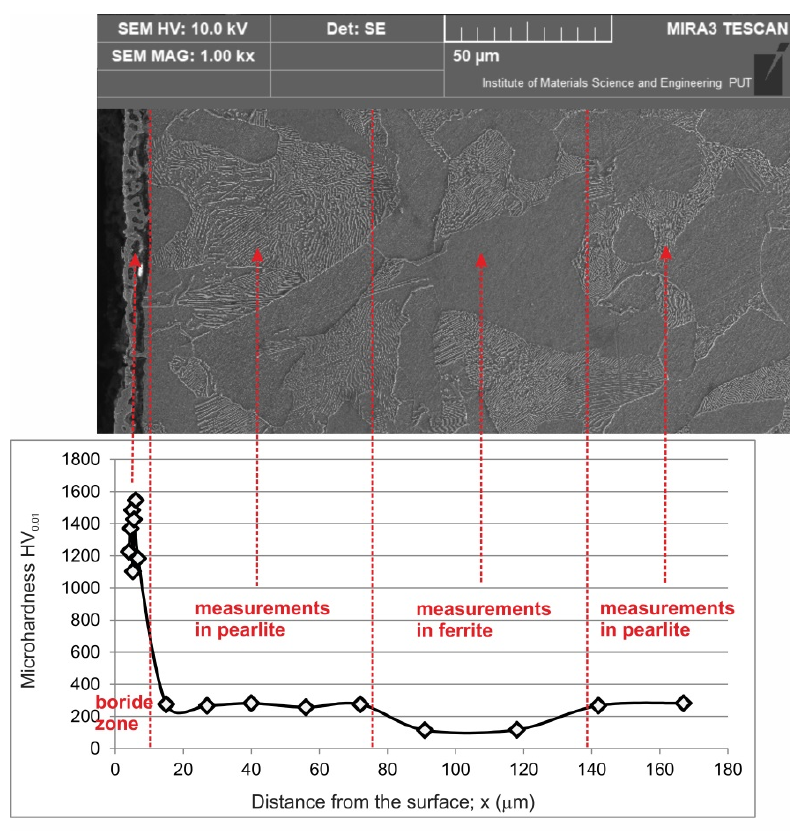
Figure 6. Microhardness profile of gas borided Armco iron in N 2 –H 2 –B(CH 3 O) 3 atmosphere at 1223 K (950 °C) for 2 h and SEM image of selected areas of measurements.